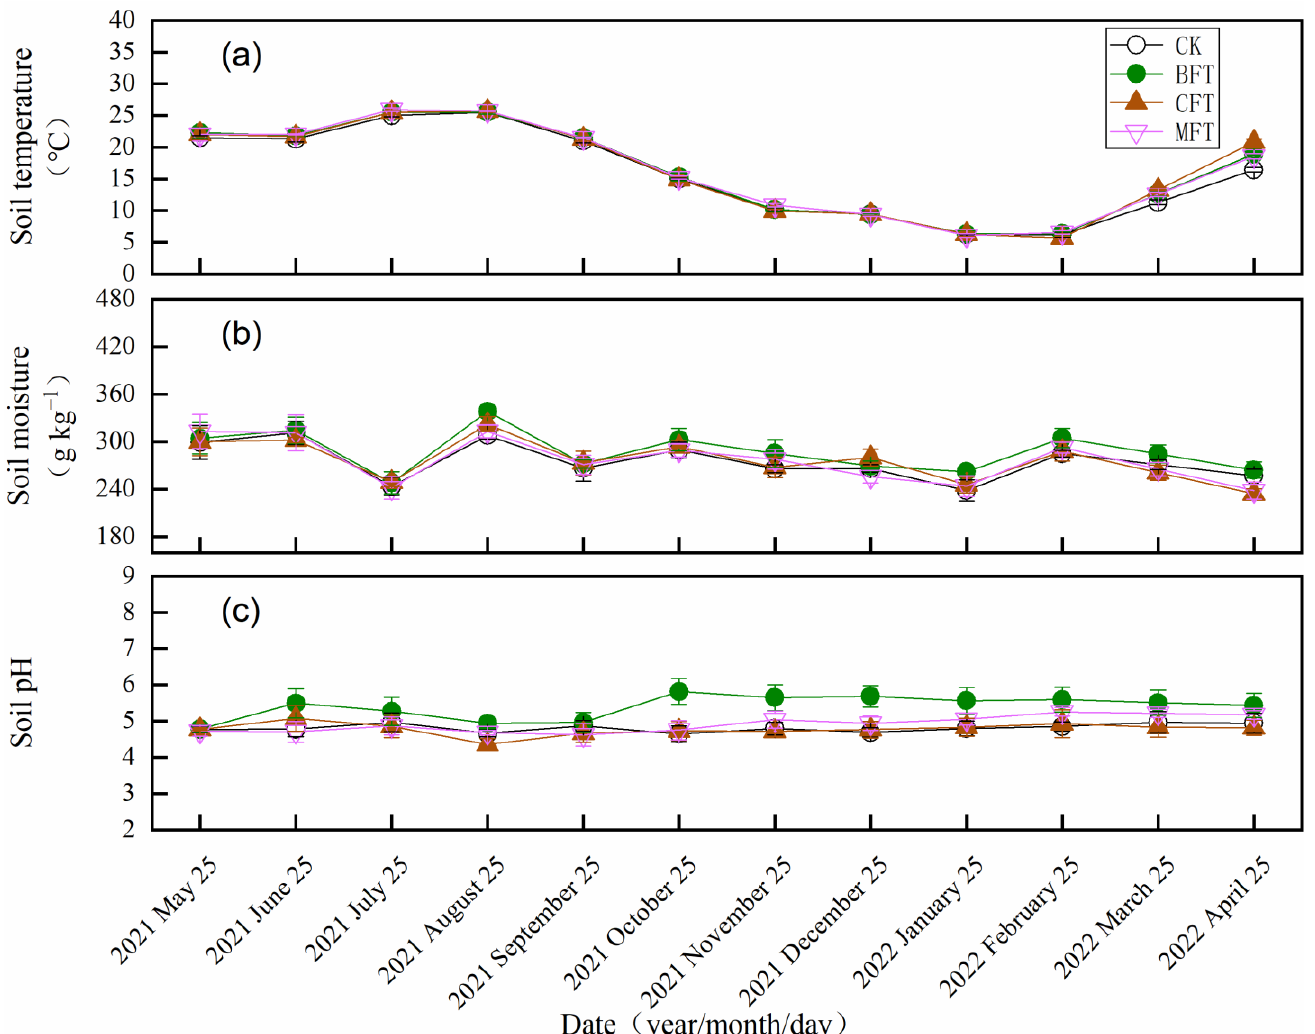
Figure 5. Effects of various fertilization strategies on soil ( a ) temperature, ( b ) moisture, ( c ) pH in the Pleioblastus amarus plantation. The standard deviation is indicated by vertical bars.